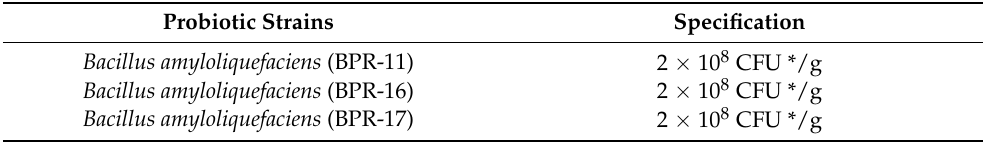
Table 3. Bacillus strains and specifications in F1 probiotics.